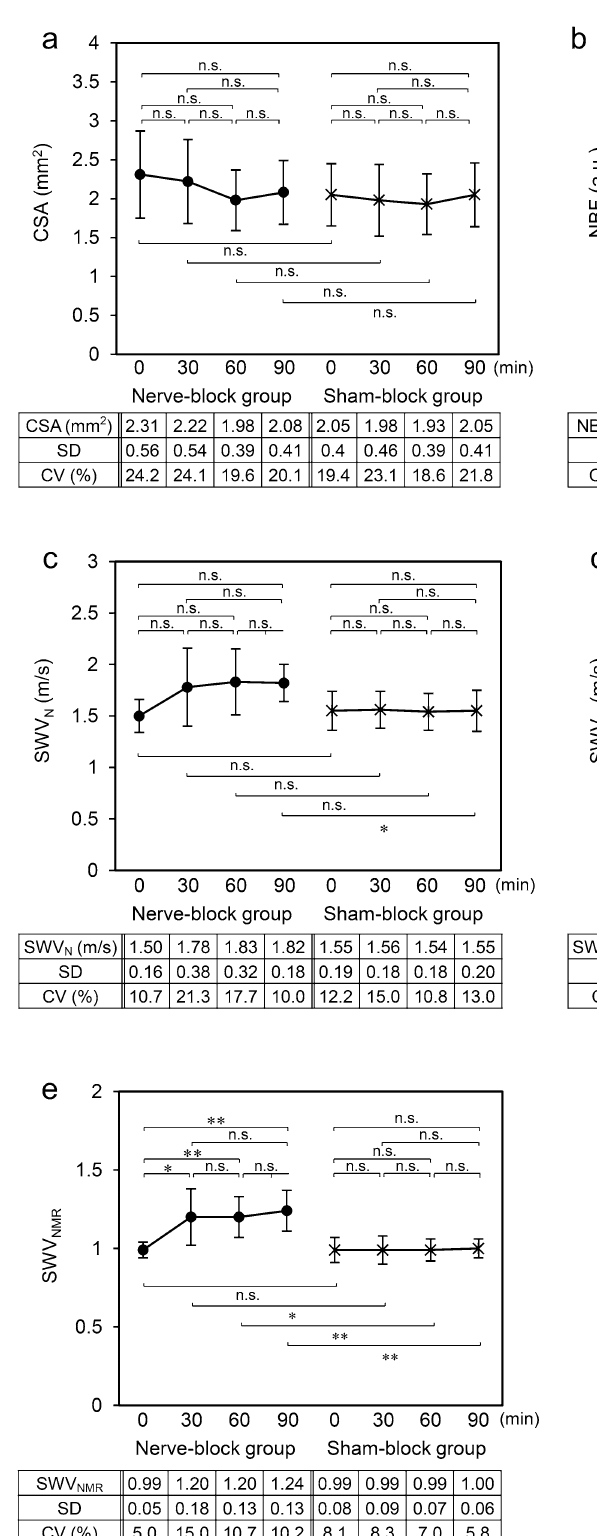
Figure 3. The change in the US parameters associated with the nerve block. ( a ) Cross-sectional area (CSA). ( b ) Nerve blood flow (NBF). ( c ) Shear wave velocity of the sciatic nerve (SWV N ). ( d ) Shear wave velocity of the muscle (SWV M ). ( e ) The ratio of shear wave velocity of the nerve to muscle (SWV NMR ). SD standard deviation, CV coefficient variance, a.u arbitrary unit. * p < 0.05, ** p <